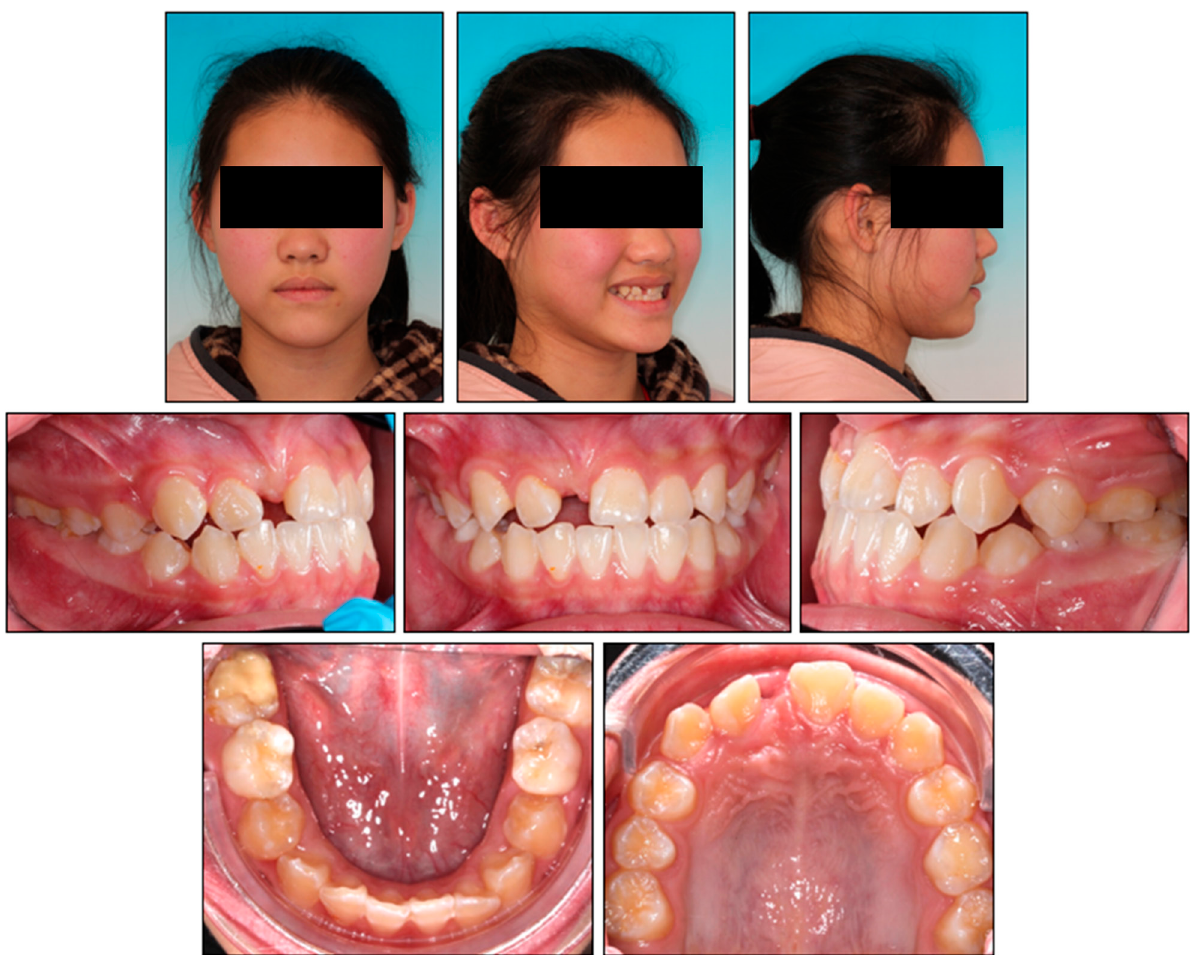
Figure 1. Pre-treatment extraoral and intraoral